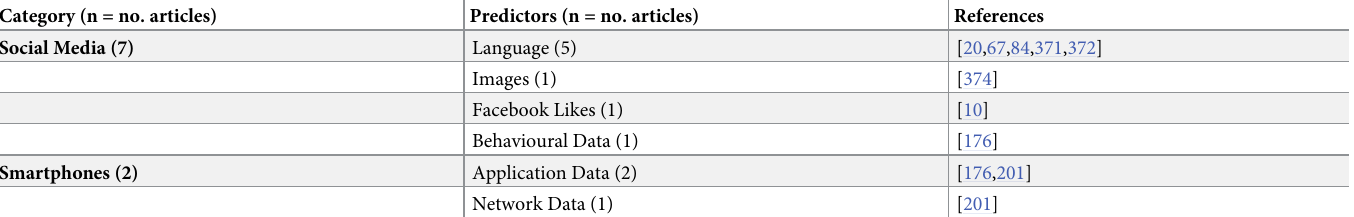
Table 26. Number of articles predicting health, with associated predictors and references.